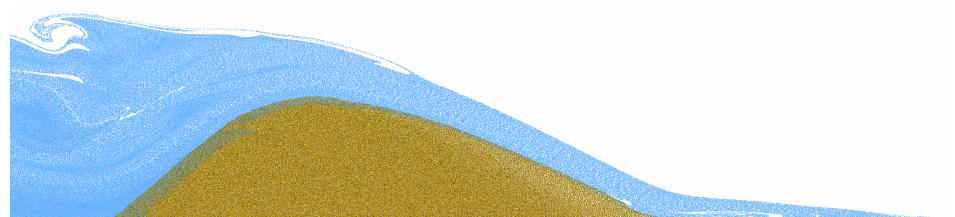
Figure 1. Overtopping dam breach